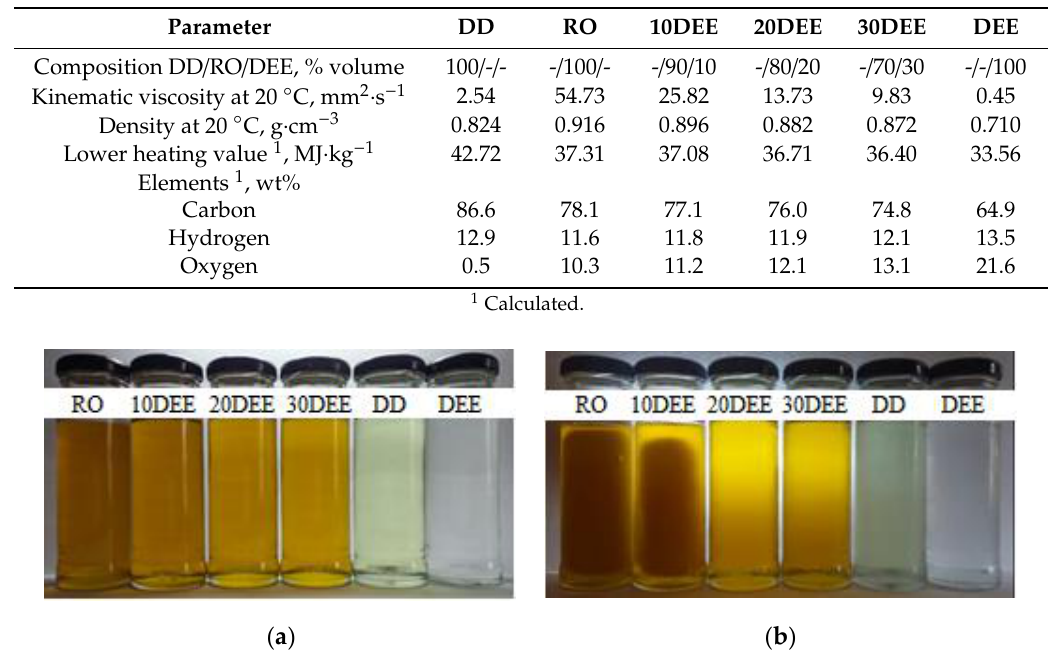
Table 3. Technical characteristics of the tested fuels.